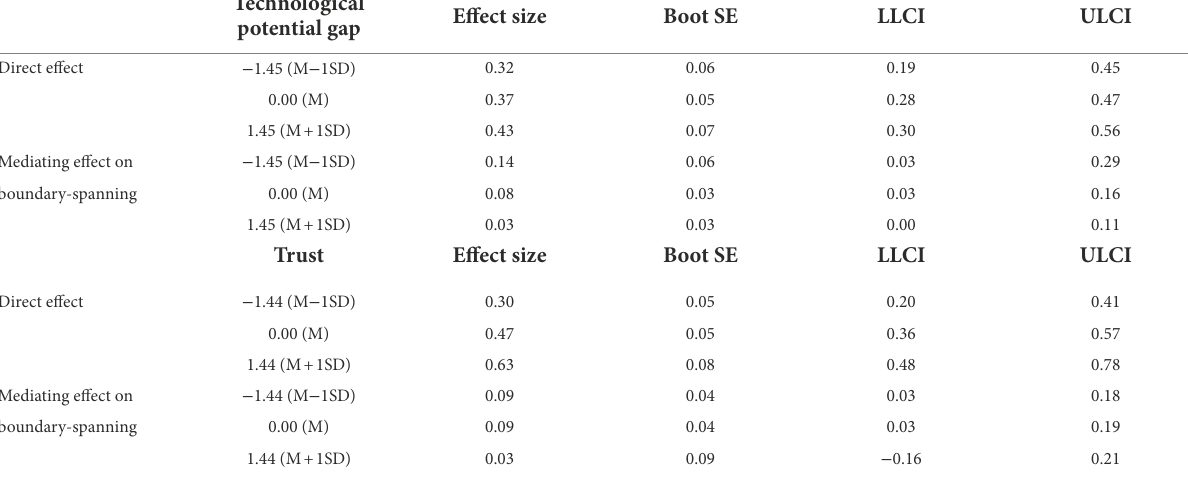
TABLE 6 Direct and mediating effects at different levels of technological potential gap and inter-organizational